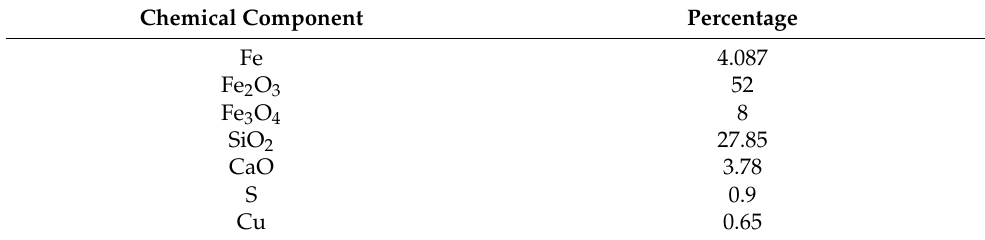
Table 5. Chemical properties of copper slag.